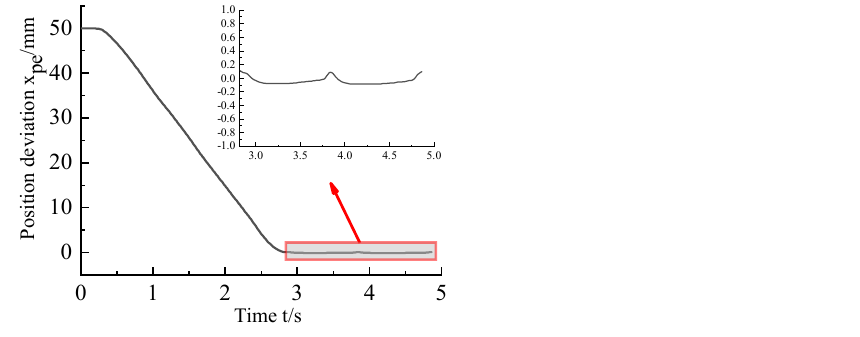
Figure 19. Response curve of step position.